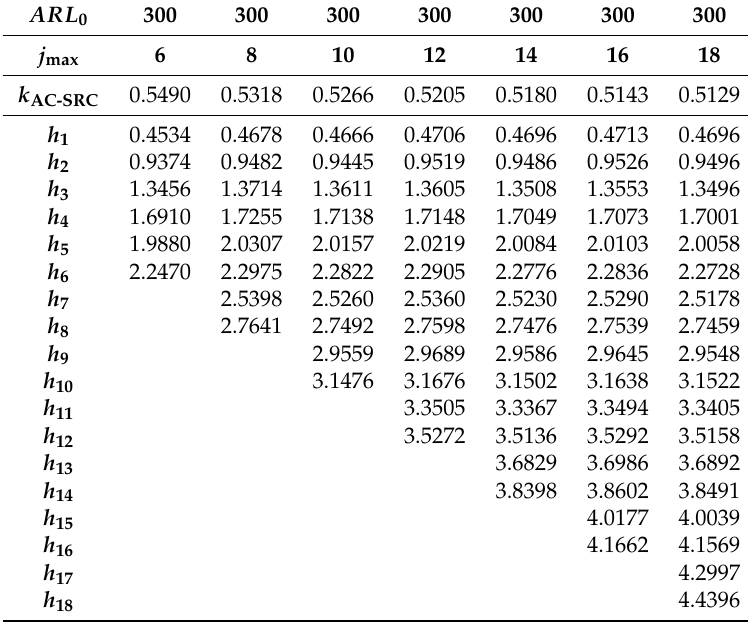
Table A3. AC-SRC for ARL 0 =